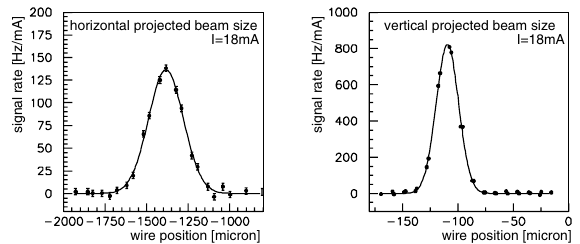
FIG. 5. Signal counts vs the laser wire position. (Left panel) horizontal scan; (right panel) vertical scan.